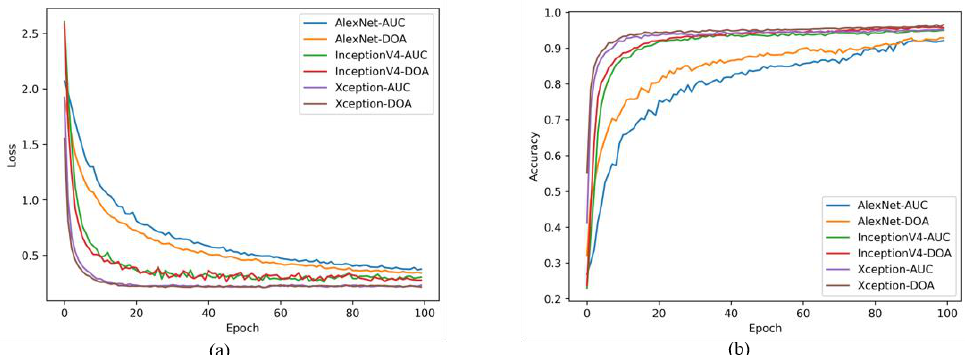
Figure 5. Accuracy and loss of image classification result. ( a ) the loss of each method in each epoch stage; ( b ) the accuracy of each method in each epoch